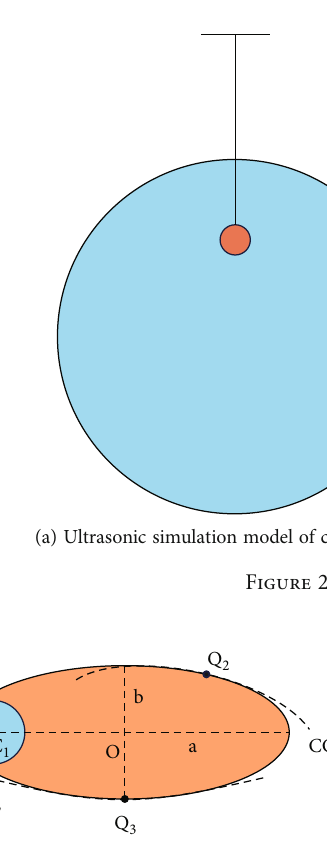
Figure 3: Schematic diagram of circular arc approximating elliptical